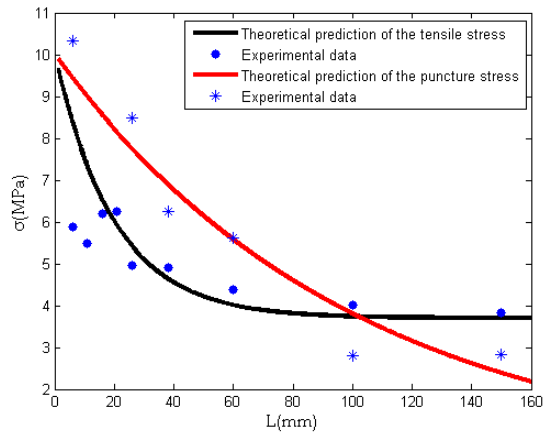
Figure 9. The relationship between needle length and mechanical properties. Table 3. The relationship between needle length and the maximal tensile stress of nanofiber membrane.